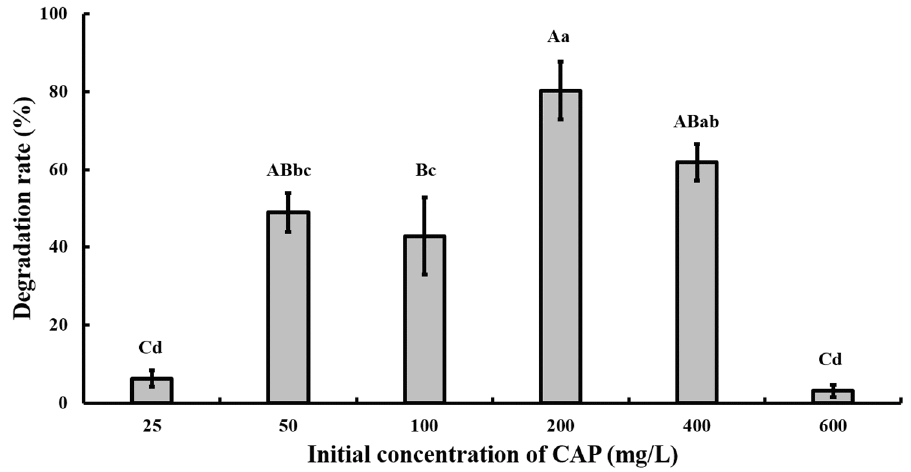
Figure 5. Effect of different initial CAP concentrations on the degradation of CAP by strain GW13. The degrading amount of CAP was measured after incubation in 28 °C, pH 7 and 1 g/L glucose adjunction for 24 h. The data are represented as the mean ± standard deviation (SD) for triplicate incubations. Different letters above the bars indicate significant differences among different treatments at p < 0.05 (uppercase) or p < 0.01 (lowercase) (one-way analysis of variance, ANOVA, and Dunnett’s test).